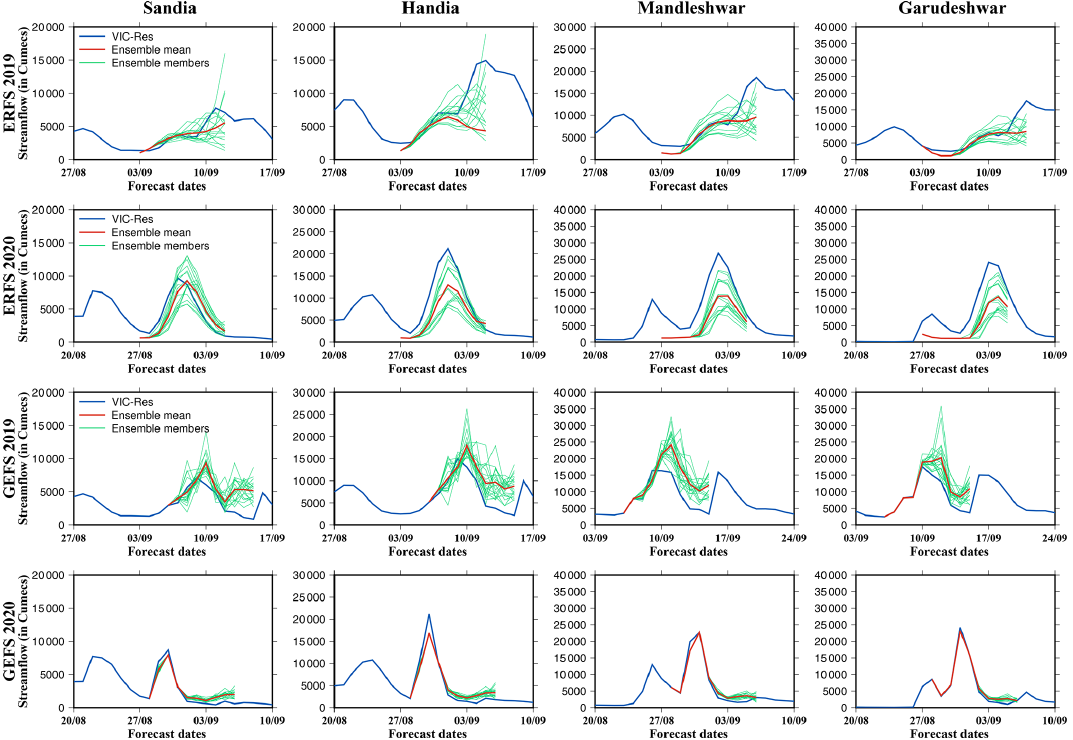
Figure 13. Ensemble streamflow simulations using the ERFS forecast at 5–11d leads and GEFS forecast at 3–5d leads against the VIC-Res simulated streamflow with the observed meteorological forcing for 2019 and